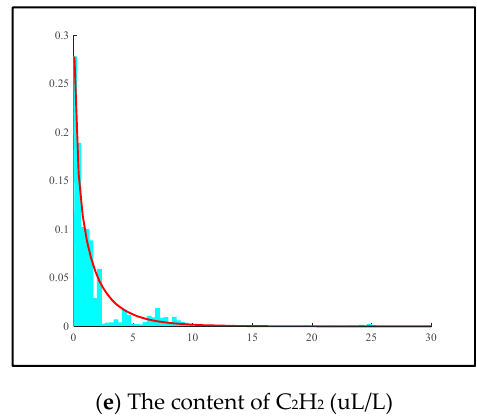
Figure 1. The probability density function curves and frequency histograms of the dissolved gas.